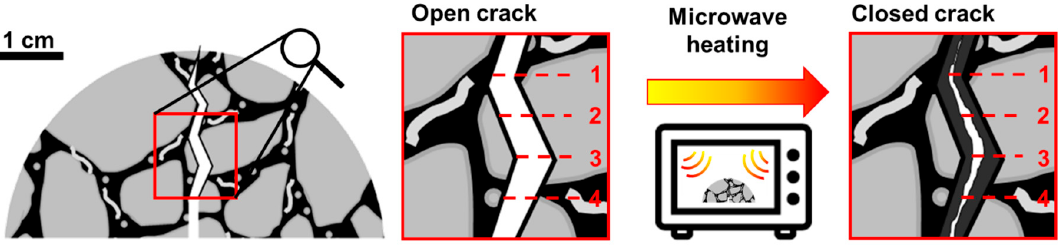
Figure 3. Schematic diagram of the measurement of the crack size before and after microwave heating.